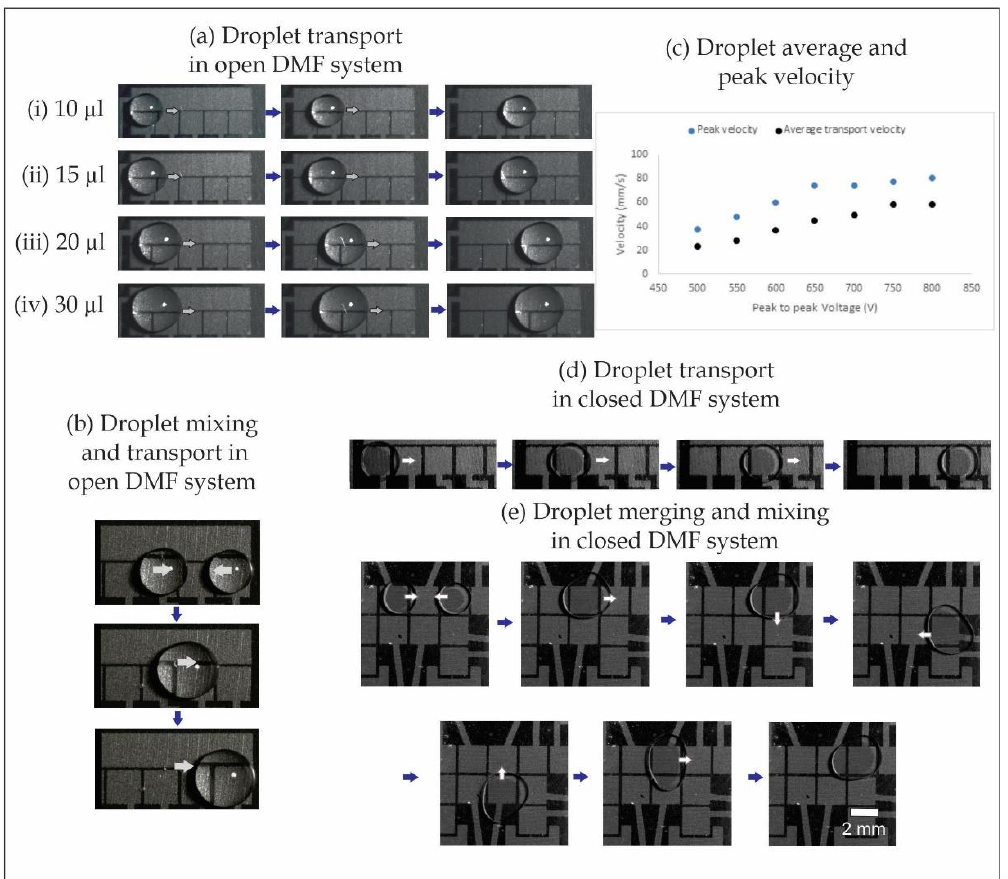
Figure 5. ( a ) Droplet-transport experiments with various droplet volumes in open DMF systems (without a top cover). ( b ) Two droplets were merged and mixed; then, the bigger droplet was transported. ( c ) The peak and averaged droplet velocities measured from the experiments. ( d , e ) Transport, merging and mixing of droplets on laser-scribed graphene-based DMF systems in a closed DMF configuration (with top cover acting as a ground electrode).